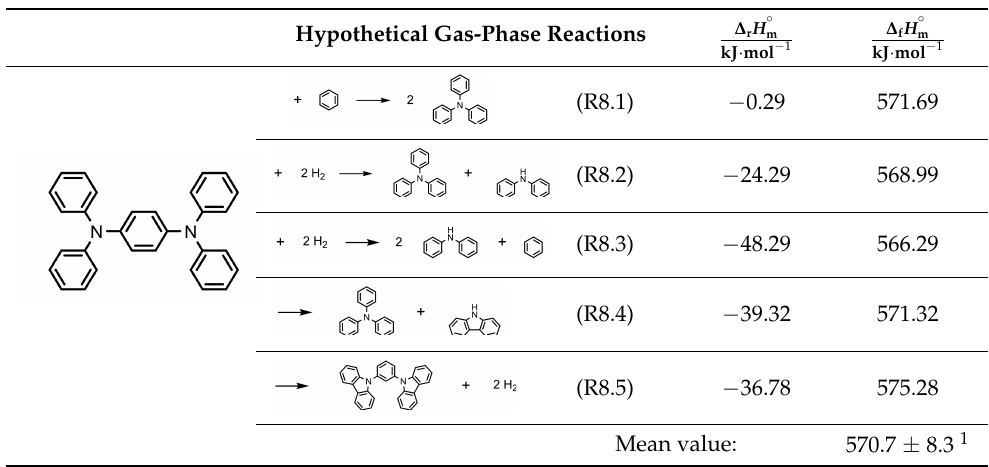
Table 8. Hypothetical gas-phase reactions and corresponding enthalpies of reactions, ∆ r H ◦ m (g), together with the calculated gas-phase enthalpy of formation, ∆ f H ◦ m ( g ) , of DAB, at T = 298.15